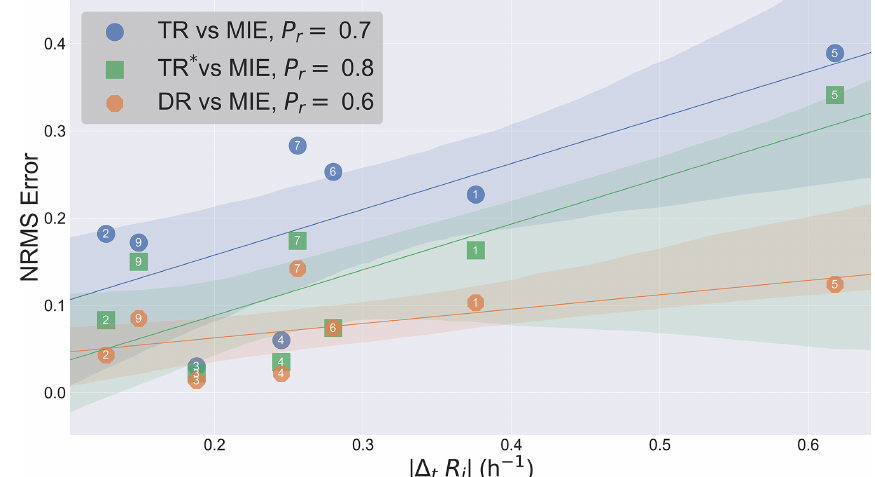
Figure 8. Correlation between the NRMS error and the change in atmospheric stability represented by the absolute change in the gradient Richardson number | (cid:49) t R i | . The shaded areas indicate the 90% confidence region. Case ID is indicated for each data point on the graph along with the calculated Pearson correlation coefficients ( P r ) for the three methods. Results indicate a strong positive correlation between the NRMS error and | (cid:49) t R i |